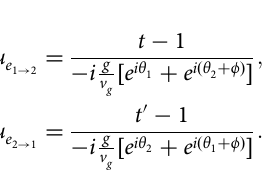
versus the coupling phase difference θ with different atomic dissipation rates. The observed phase-dependent nonreciprocal transmission can be easily understood by resorting to Eqs. (6a) and (7a). For instance, it is viable to have t = 0 ( t 0 ¼ 0) in the case ¼ (cid:2) 4 Γ sin ϕ sin θ ). Thus, perfectly nonreciprocal transmission ( γ e denoted by I = ± 1 can be attained by tuning the accumulated phase ϕ and the coupling phase difference θ if we have ∣ Δ ∣ ≤ 2 Γ and ≤ 4 Γ . Note, in particular, that the conditions for attaining I = ± 1 γ e ¼ ± 4 Γ sin ϕ as well as will reduce to θ = π /2 + 2 n π and γ e θ = − π /2 + 2 n π and γ ¼ (cid:5) 4 Γ sin ϕ for Δ = 0, with n being an e arbitrary integer.